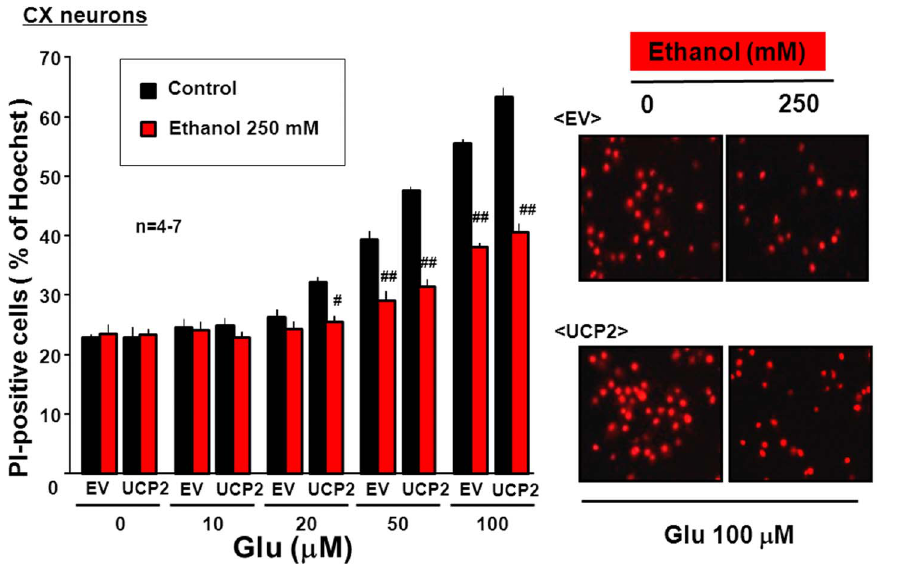
Figure 5. Effects of ethanol on cellular survival in cultured neurons with UCP2 overexpression. Murine neocortical neurons were cultured for 4 days, followed by infection with lentiviral UCP2 or EV expression vector and subsequent further culture for an additional 4 days. Cells were then exposed to Glu at concentrations of 10 to 100 m M for 1 h in either the presence or absence of 250 mM ethanol, followed by further culture for an additional 24 h and subsequent DNA staining with Hoechst33342 and PI for determination of cellular viability. Values are percentages of PI- positive cells over Hoechst33343-positive cells in 4–7 independent determinations. # P , 0.05, ## P , 0.01, significantly different from the value obtained in cells not exposed to ethanol. Statistical significance was determined according to the 2-way ANOVA test analysis.